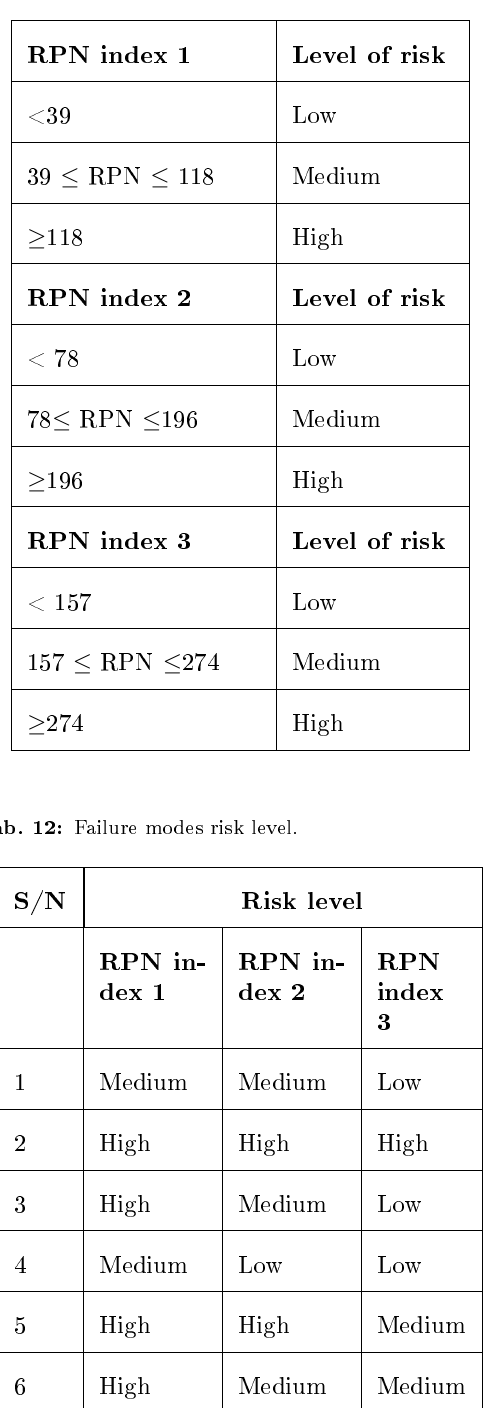
Tab. 11: Risk level indexes.